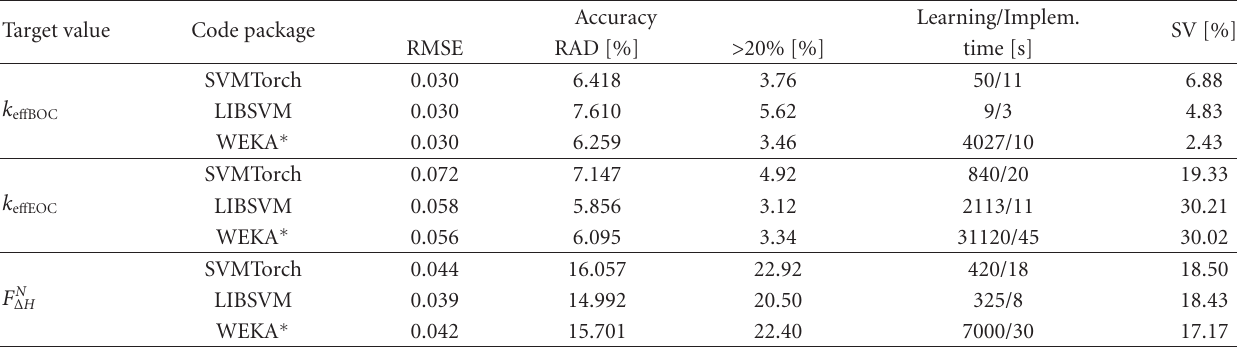
Table 2: Comparison results for PF kernel function.